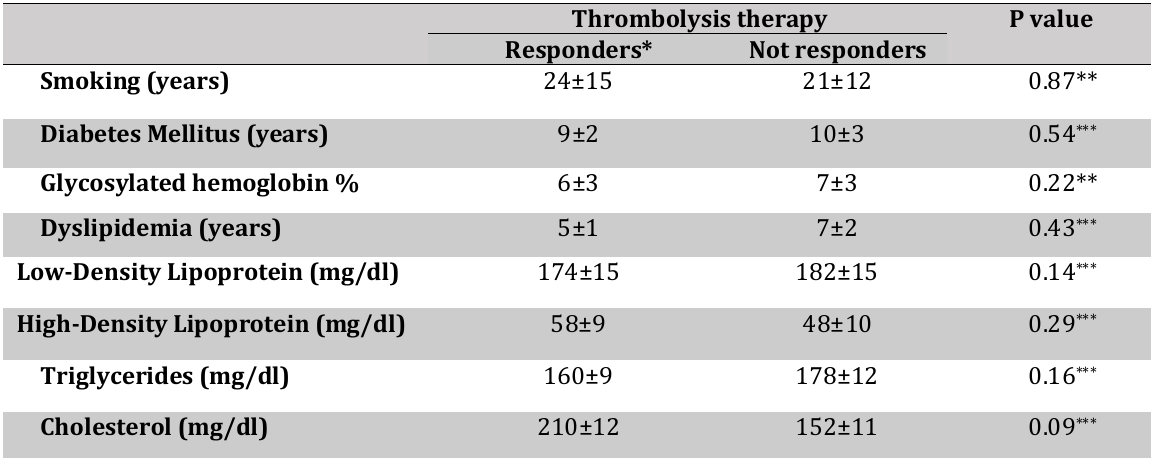
Table 2 . Differential analysis of cardiovascular disease risk factors upon the success of the thrombolysis